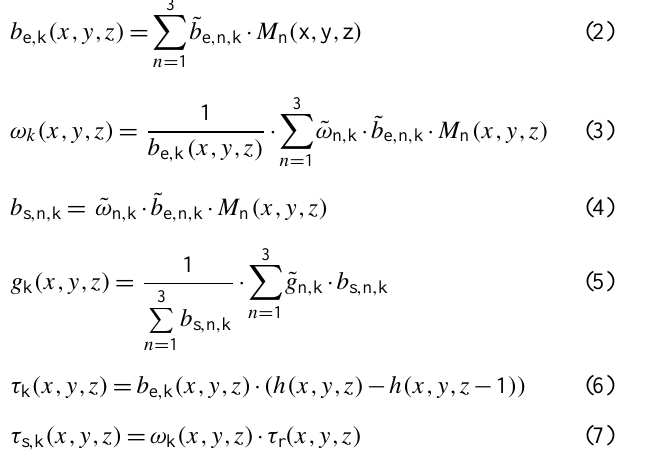
Figure 2: Model domain and stations used for comparison with model results. ( Ag – Agoufou, Ci – Cinzana, Da – Dakar, Dj – Djanet, Ho – Hombori, Ma – Maine Soroa, Ni – Niamey).